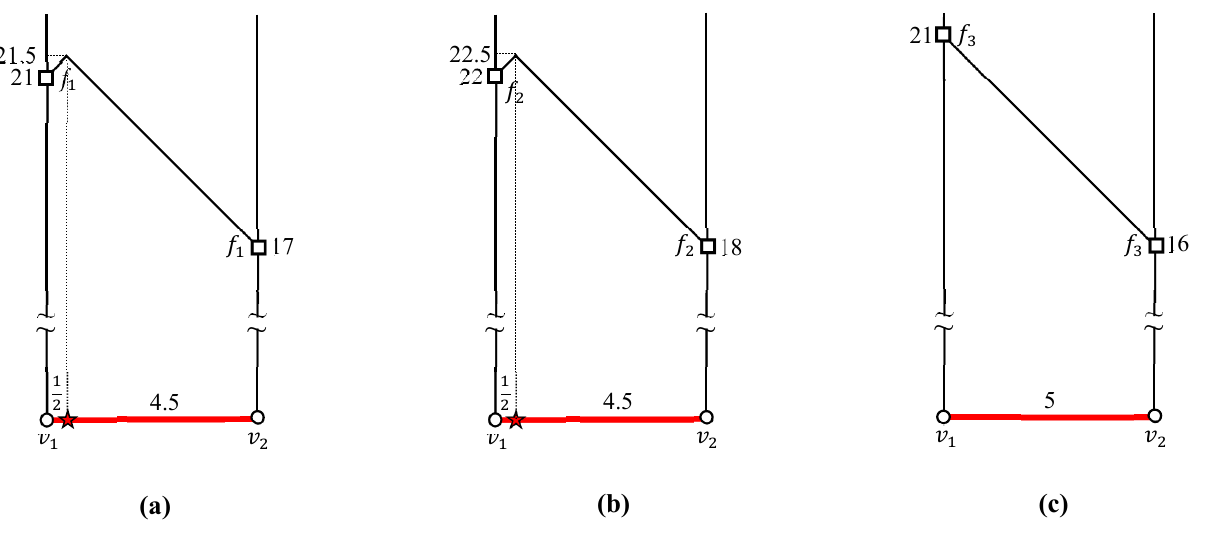
Figure 12. Changes in the distance from each candidate facility f to a query point q in v 1 v 2 : ( a ) change